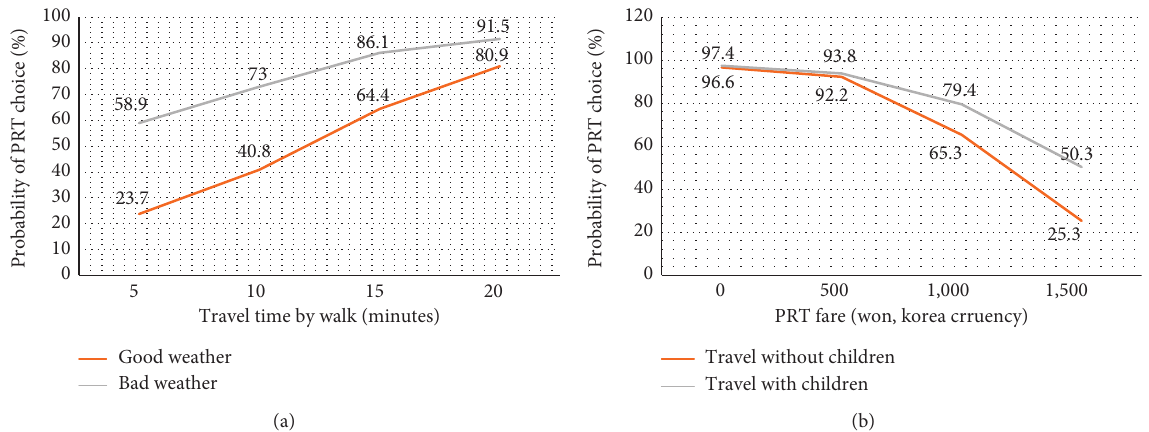
Figure 3: Pilot survey results of weather and companion conditions: (a) weather condition; (b) companion condition (travel with children).